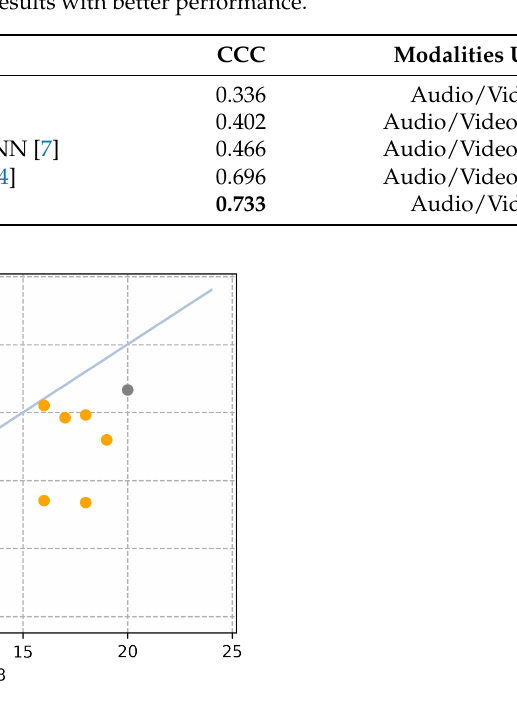
Figure 4. Correlation graph between the predicted and true PHQ-8 scores. Each color represents different